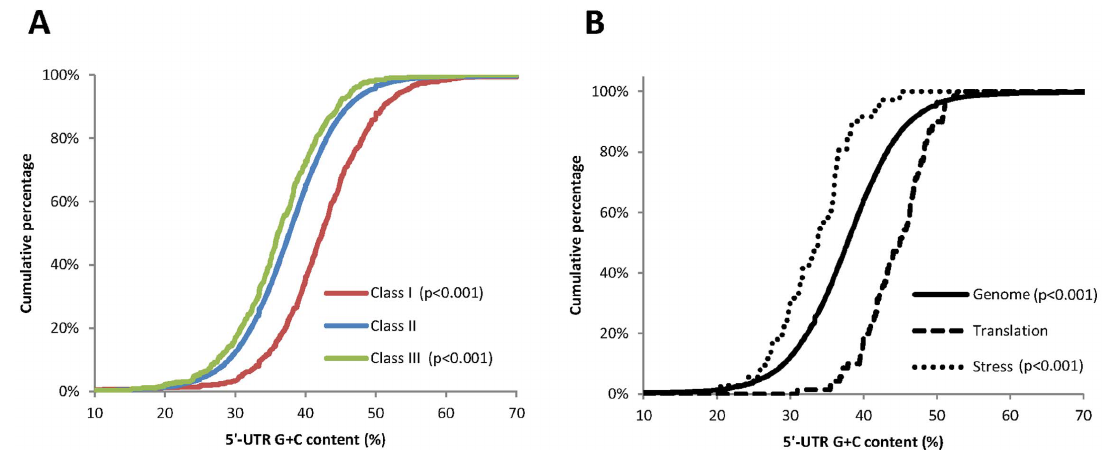
Figure 7. Heat selectively activates translation of transcripts with low 5 9 -UTR G + C content. Distribution analysis of the percentage of G + C content in the 5 9 -UTR of the mRNAs belonging to ( A ) the three translational classes described in Figure 4A or ( B ) within the whole Arabidopsis genome (solid line, n=16098), within the genes in class I related with translation (dashed line, n=70) or within the genes in class III related with stress (pointed line, n=36). Statistical differences were determined by K–S test using class II or the whole genome as a reference in ( A ) and ( B ), respectively. P-values, to determine statistically significant differences, are also shown.